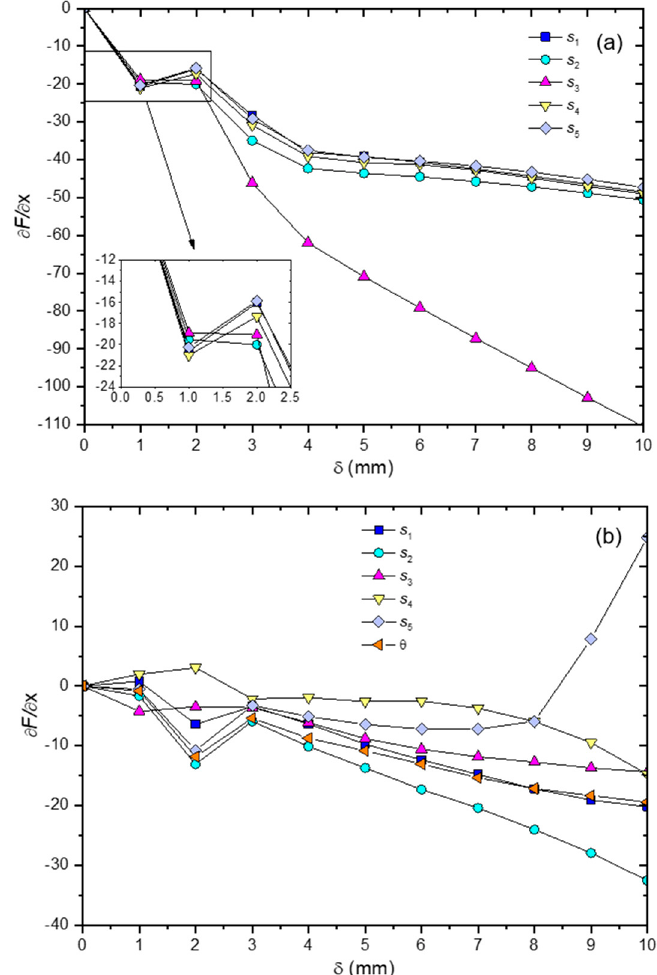
Figure 10. Sensitivity analysis results of flexural force variation with respect to the geometric ∂ F parameters variation in function of displacement ( δ ) for the ( a ) 0OPT and ( b ) AOPT ∂ x